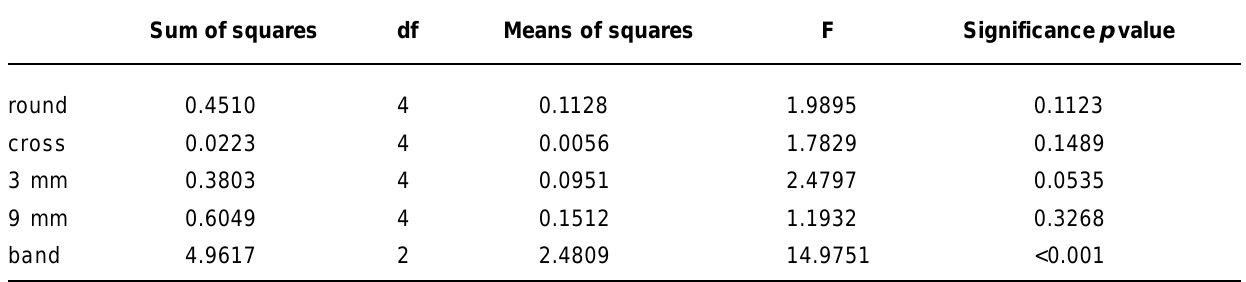
TABLE 3- Results of ANOVA (p=level of significance)